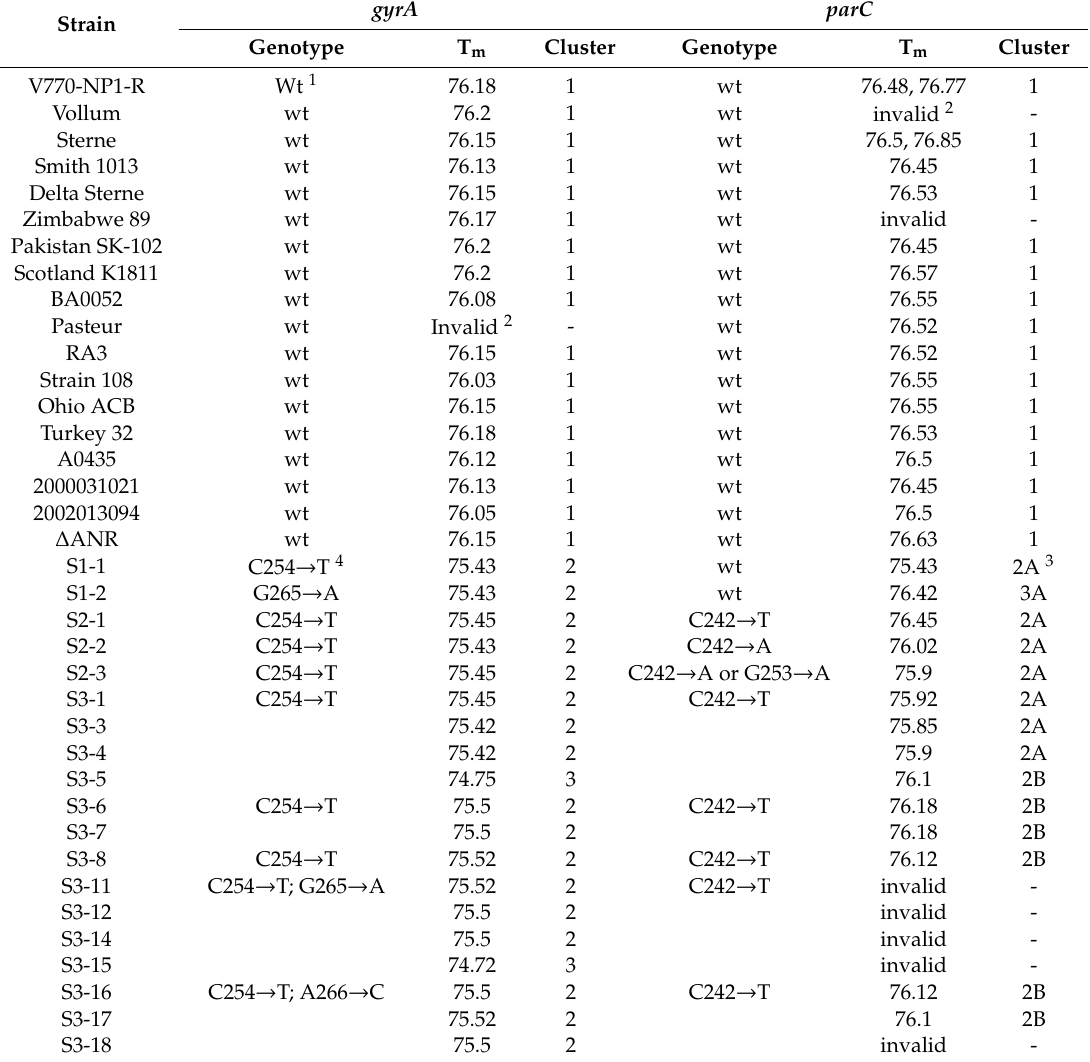
Table 7. HRMA melt temperatures and clusters for B. anthracis strains (wild-type and mutant). Strain